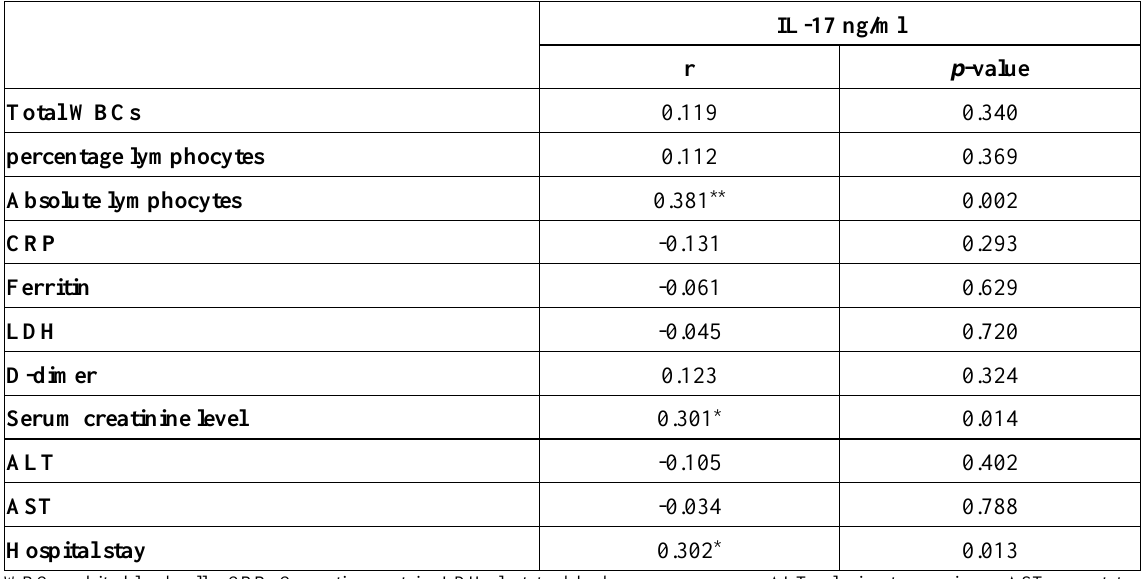
Table 3. Correlation of serum IL-17 level with different laboratory parameters and hospital stay.